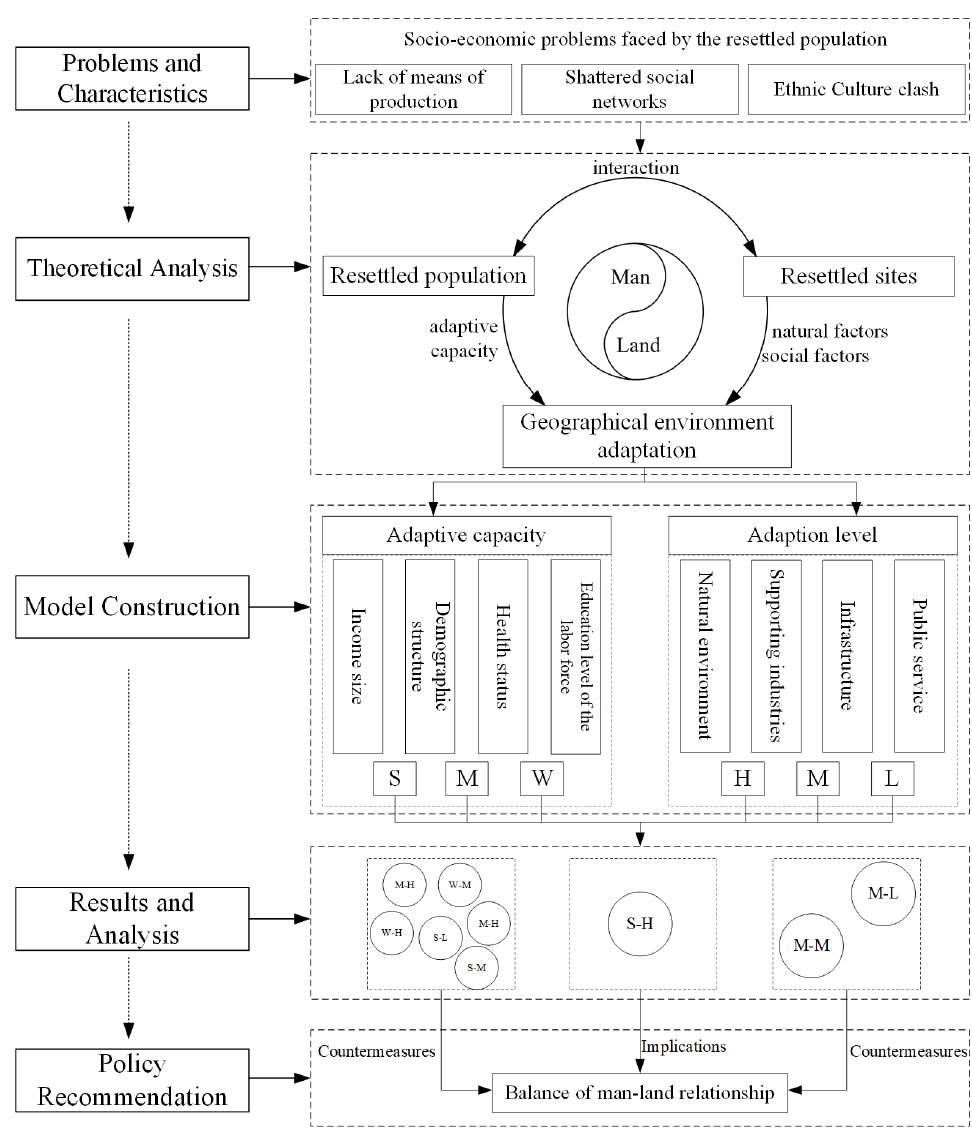
Figure 1. Conceptual framework. Note: In the conceptual framework, “S”, “M” and “W” represent that AC is strong, medium and weak, respectively; “H”, “M” and “L” represent that AL is high, medium and low, respectively.